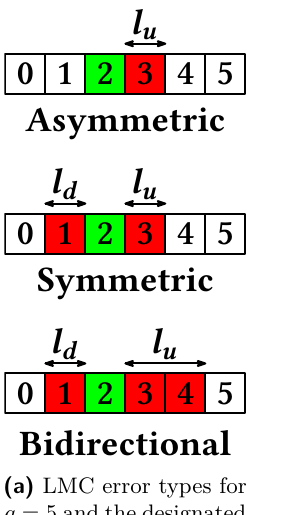
(b) q -ary asymmetric channel model for l = 1 between symbols. Non-wrap around channel (solid lines only) and wrap-around channel (solid lines and dashed line as wrap-around). Figure 8: LMC error types and q -ary channel